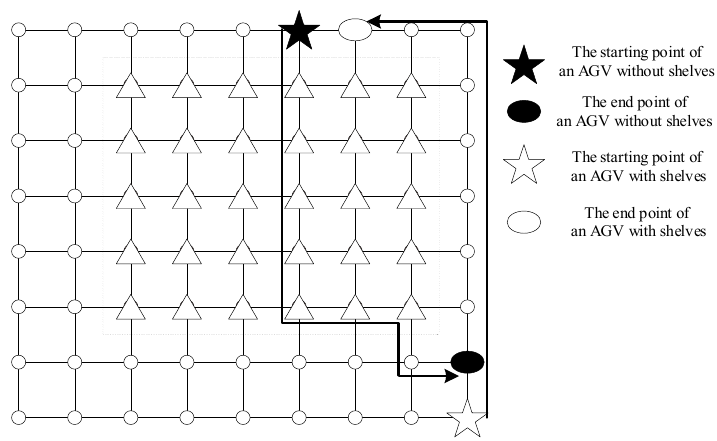
Figure 8. Path planning of AGV based on the improved A* algorithm.